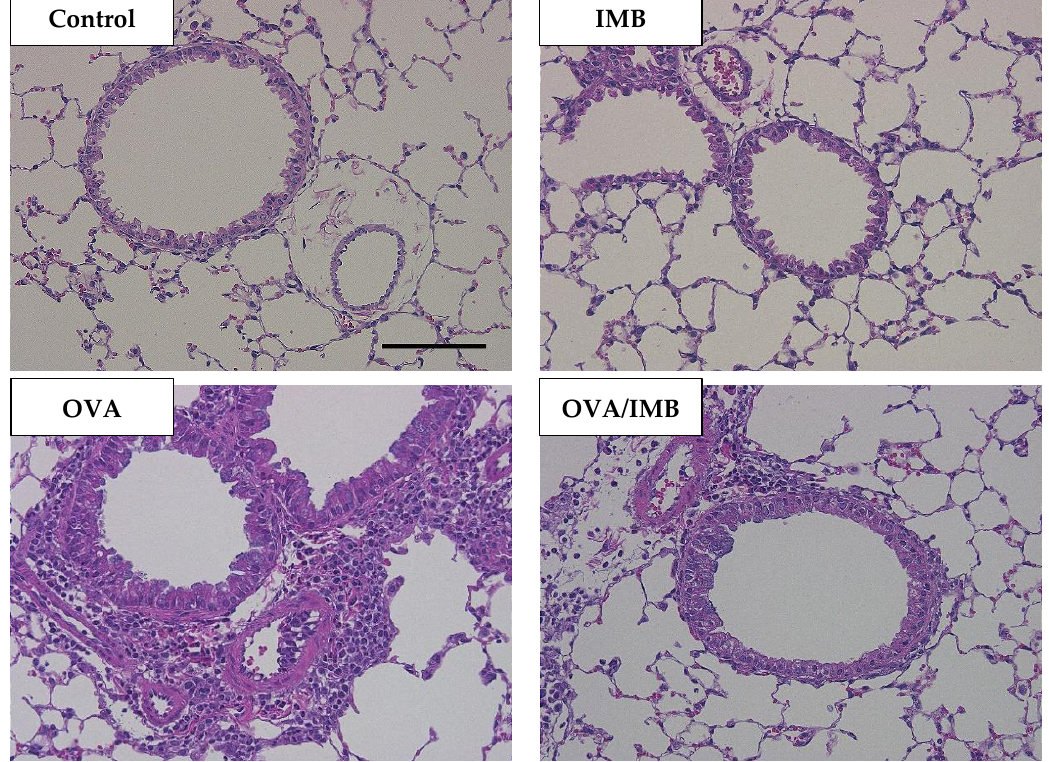
Figure 6. Representative images of lung tissues by HE staining from each group are shown at 200× magnification. Scale bar = 100 µm.